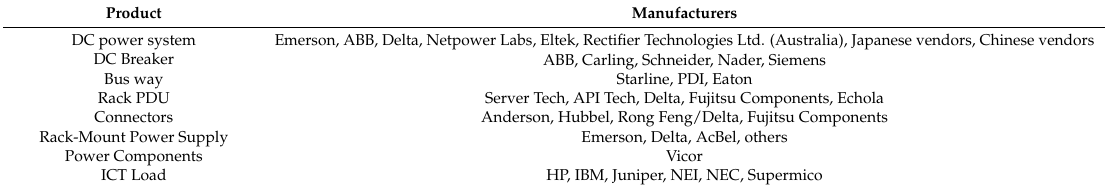
Table 6. Companies providing 400 Vdc